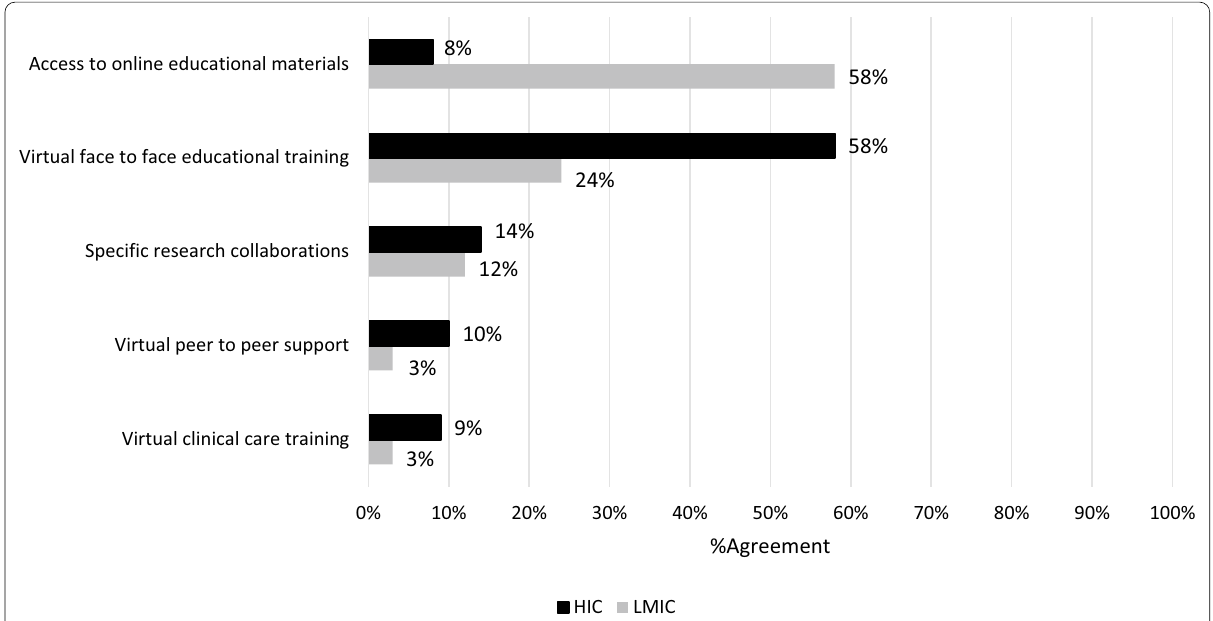
Fig. 1 Most highly preferred virtual global Health partnership initiatives (VGHPIs) during the COVID‑19